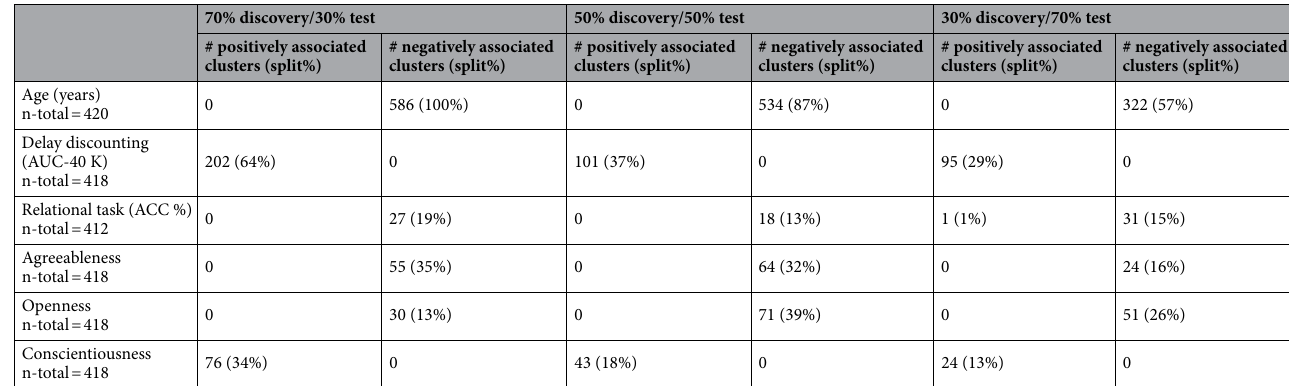
Table 1. Summary of exploratory findings. For each discovery sample size, the number of clusters in which cortical thickness is positively or negatively associated with the tested phenotypic or psychological score is reported. The number of splits (out of 100) in which the clusters were detected are noted in parentheses (i.e. % of splits with at least one significant cluster [in the respective direction]). AUC area under the curve, ACC